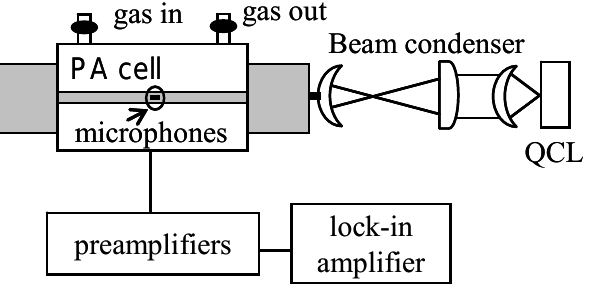
Figure 2. Schematic diagram of the photoacoustic